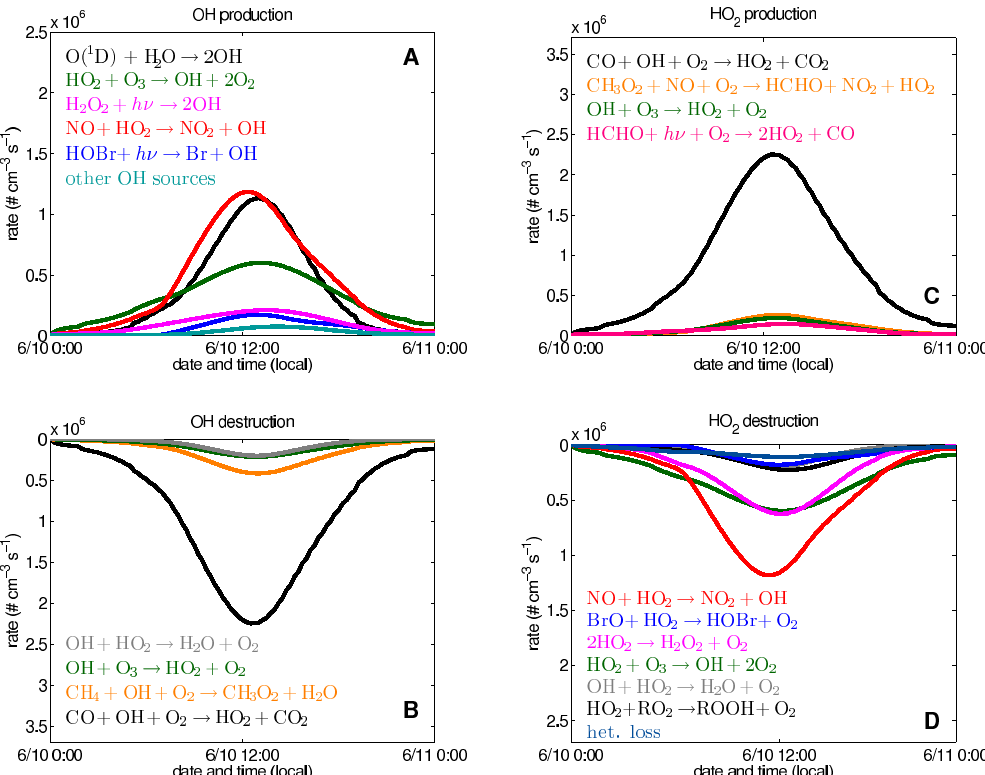
Fig. 12. OH and HO 2 production and destruction reaction rates in panels (a – d) , including primary production, HO 2 to OH cycling reactions, and terminal loss processes on June 10, 2008.